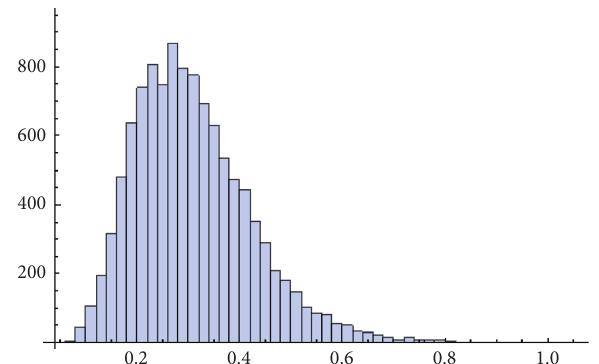
Figure 6: The histogram of θ